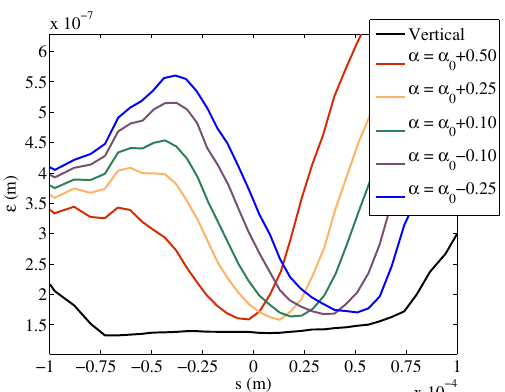
FIG. 21. Simulated horizontal slice emittance along the bunch for different beam optics settings in the bunch compressor for a compression factor of 15, obtained with the large-mismatch bunch as input distribution. The vertical slice emittance is also shown for